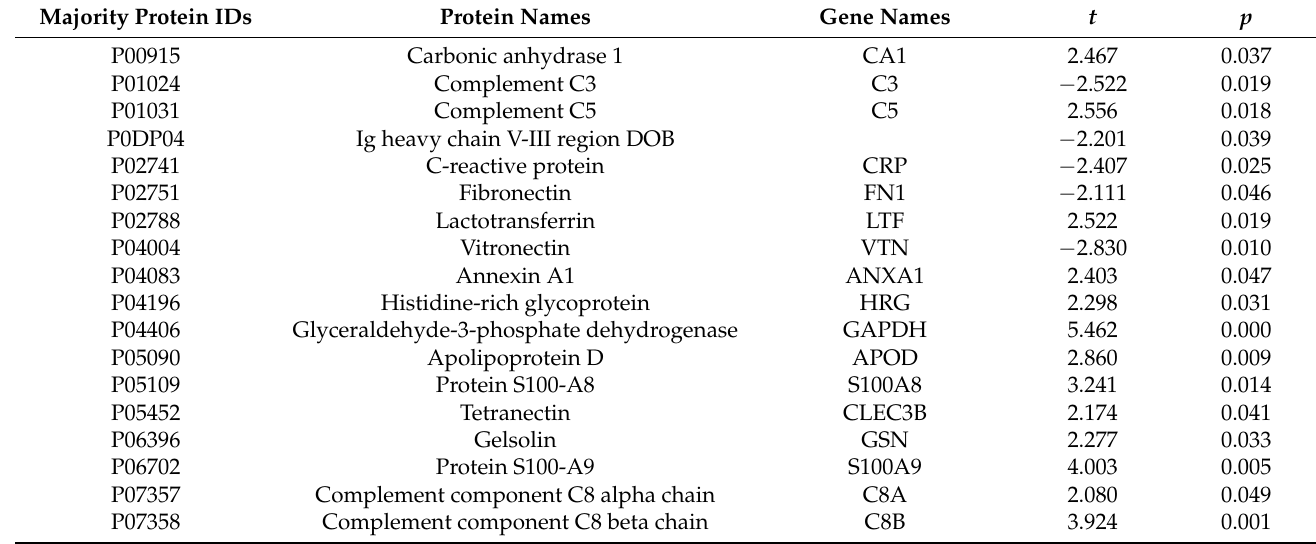
Figure 4. Individual differences in plasma protein levels among the 24 plasma samples. ( A ) Analysis of protein abundance of LPA, CRP, and PZP in 24 plasma samples. ( B ) Analysis of protein abundance of SELL, C6, CLU, and HPX in 24 plasma samples. Table 3. Differential proteins in the normal control group and gout